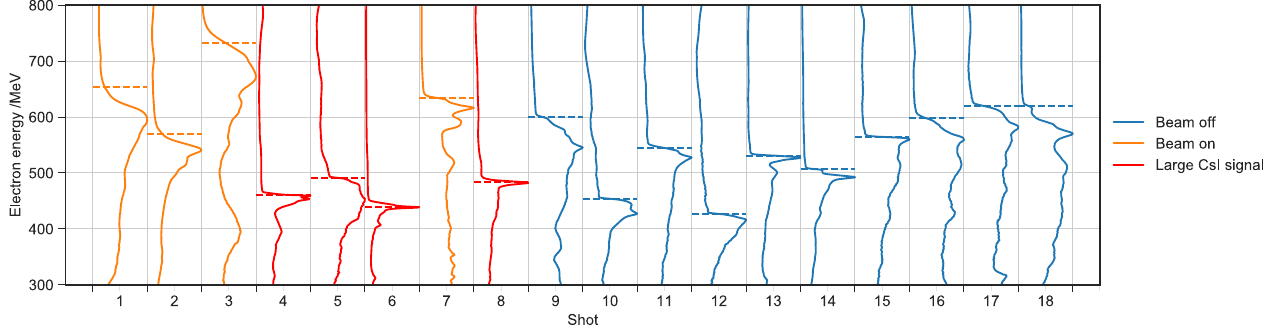
FIG. 4. Consecutive electron spectra. Each spectrum has been normalized to its own maximum.